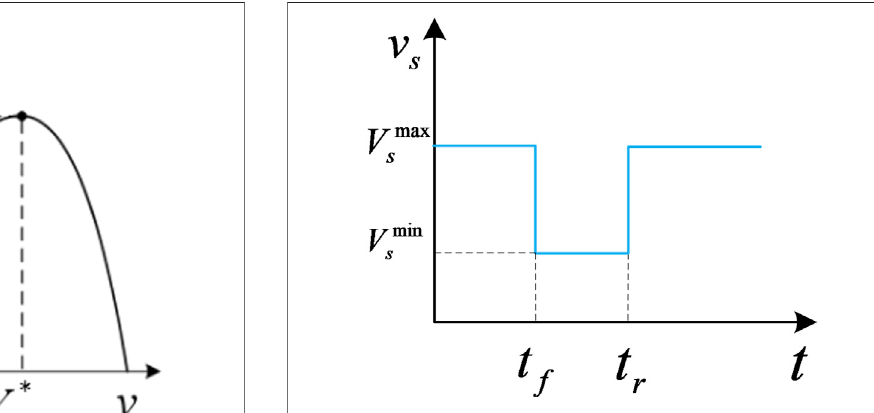
FIGURE 4 | Variation process of DC source